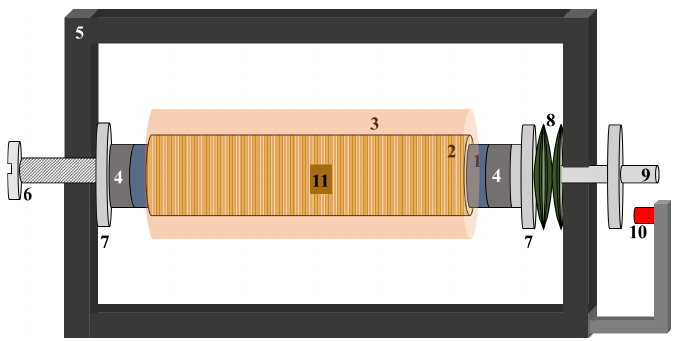
Figure 1. Sketch of a linear magnetostrictive actuator (not to scale) showing the typical elements: 1, Magnetostrictive rod; 2, Pickup coil; 3, Excitation coil; 4, Permanent magnets; 5, Iron sheets; 6, Prestress screw/system; 7, Supports; 8, Washer springs; 9, Output shaft; 10, Displacement sensor; 11, Hall